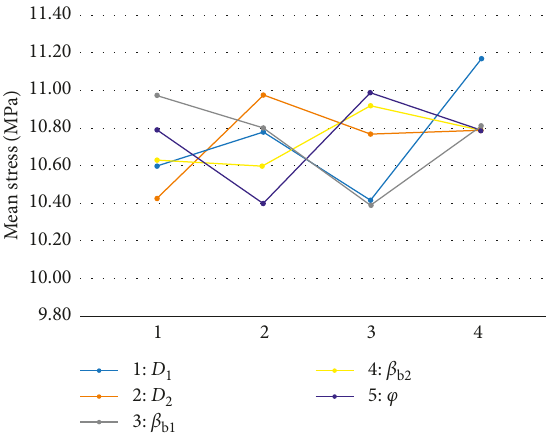
Figure 14: Influence trend of various parameters on stress. Table 10: Comprehensive weighted score value table of orthogonal experimental results of the plastic-lined pump structure.